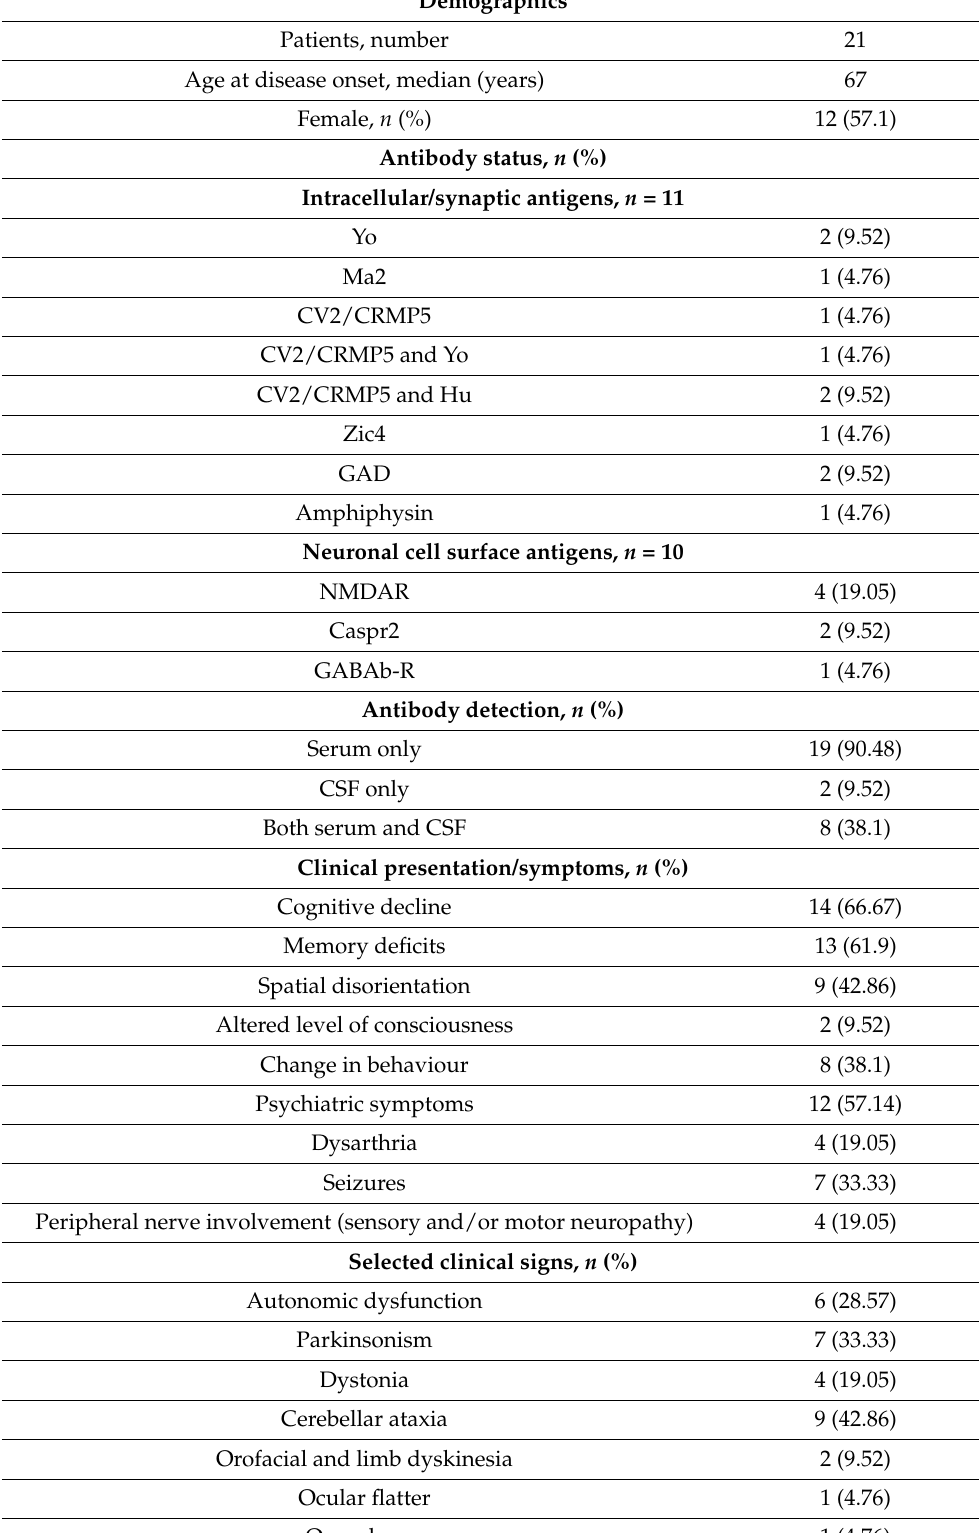
Table 1. Demographic and clinical/paraclinical data of the patients included in the